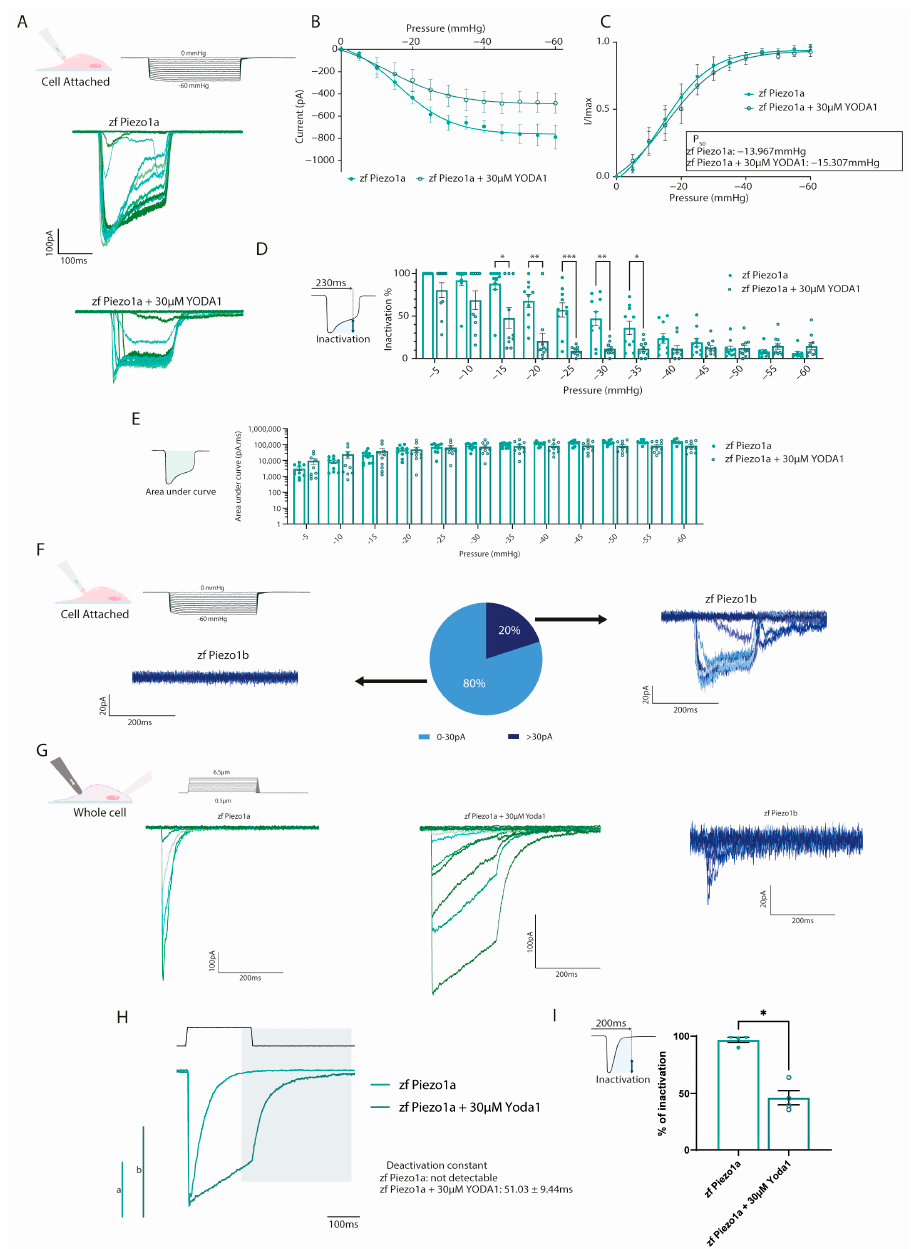
Figure 2. Electrophysiological recordings of zebrafish Piezos. ( A – D ) Cell-attached recordings obtained from HEK293T transfected with pIRES2-EGFP- piezo1a . n = 10 for each condition. ( A ) Representative zfPiezo1a traces obtained in untreated cells or cells treated with 30 µ M Yoda1. ( B ) Current–pressure relationship. ( C ) I/Imax normalization fitted with Boltzmann equation. The average P 50 was calculated from the fitting curve of each condition. ( D ) Proportion of inactivated channels 230 milliseconds after the beginning of a sweep (still under mechanical stimulation). ( E ) Area under curve calculated for cell-attached recordings. ( F ) Heterogeneity of the currents recorded in the cell-attached configuration in zf Piezo1b-transfected cells. ( G ) Representative whole-cell recordings obtained in cells transfected with either pIRES2-EGFP- piezo1a untreated (zf Piezo1a) or treated with 30 µ M of Yoda1 (zf Piezo1a + 30 µ M Yoda1) or pIRES2-EGFP- piezo1b (zf Piezo1b) and stimulated using mechanical